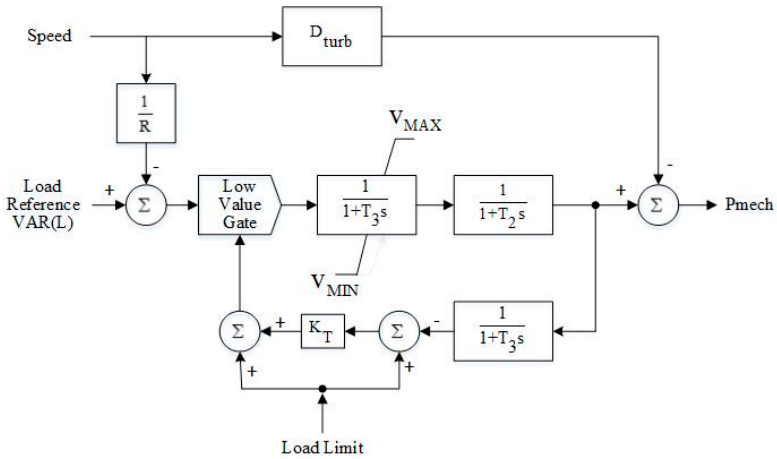
Figure 1. The gas-turbine model [36].